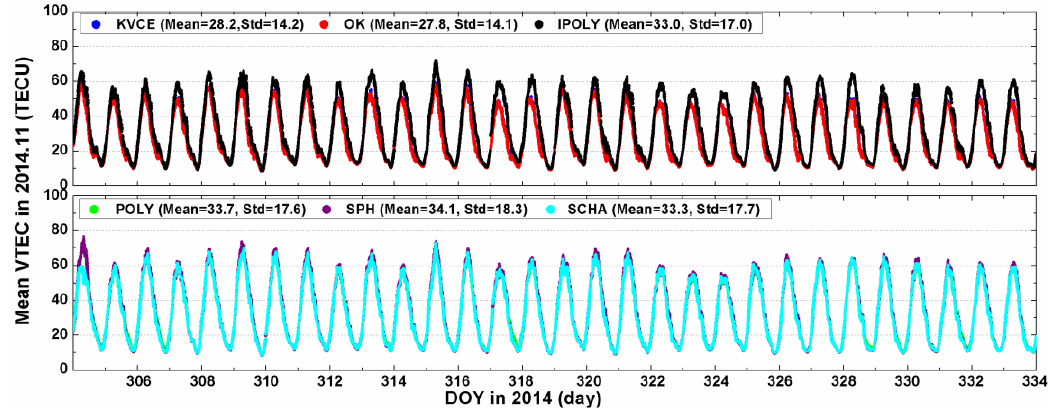
15 of 24 Figure 4. The VTEC maps obtained by different approaches at local time 14:00 on DOY 305 of 2014. Figure 5 shows the time series of China regional mean VTEC values obtained from different models. In order to avoid overlapping of resultant curves, they are plotted into two groups to conveniently distinguish the differences among them. The distributions show similar ionospheric behaviors in spite of somewhat differences. The maximum VTEC, which can reach nearly 80 TECU, occurs during LT 12:00 to LT 14:00 due to intense activities of ionosphere. Then the VTEC gradually decreases to the minimum, ranging from 10 to 15 TECU. The overall mean and standard deviations